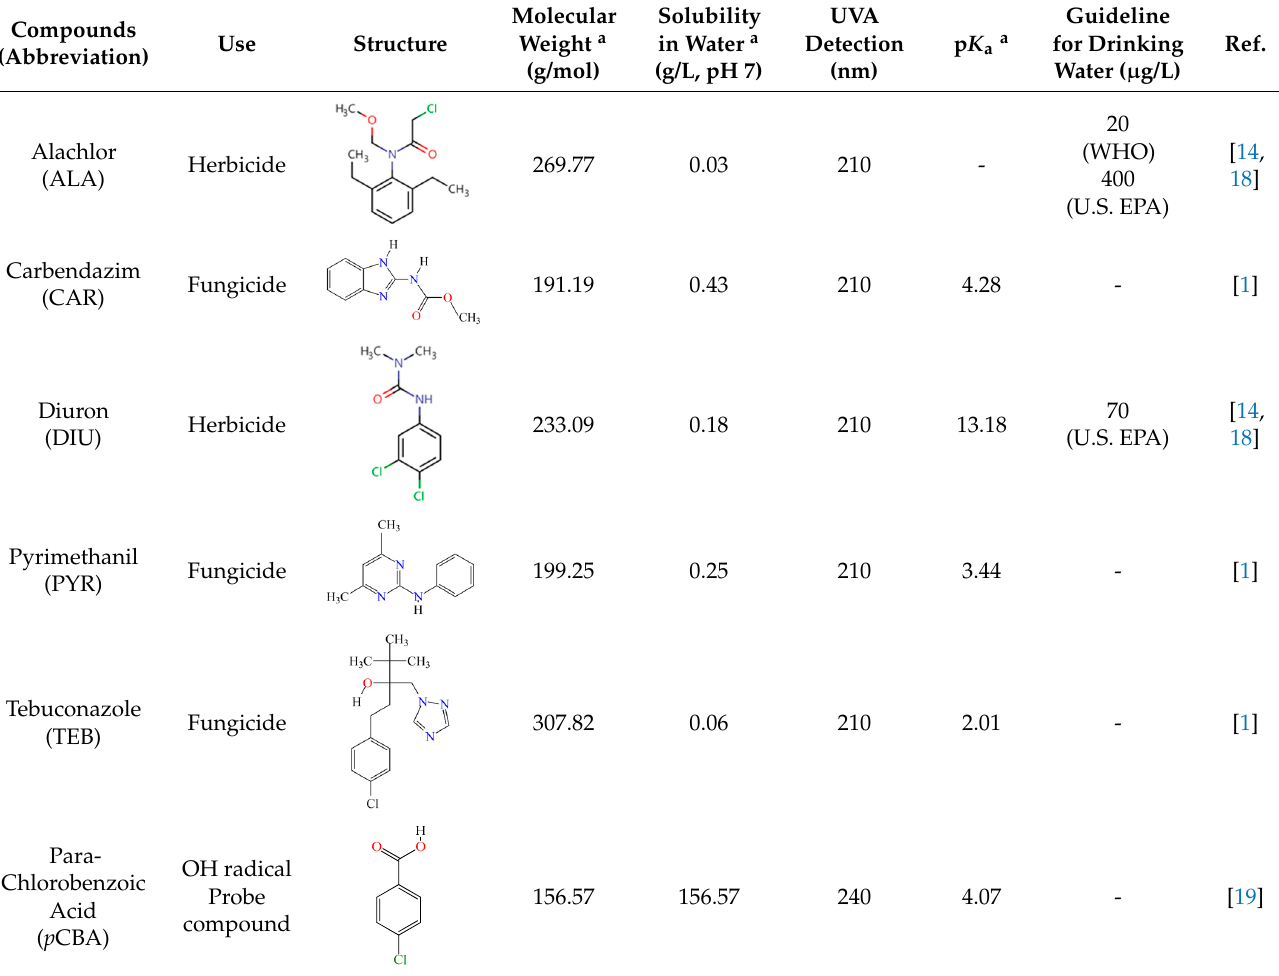
Table 1. Table 1. Table 1. Physicochemical characteristics of the selected Table 1. Physicochemical characteristics of the selected pesticides. Table 1. Physicochemical characteristics of the selected pesticides. Table 1. Physicochemical characteristics of the selected pesticides. Table 1. Physicochemical characteristics of the selected pesticides.